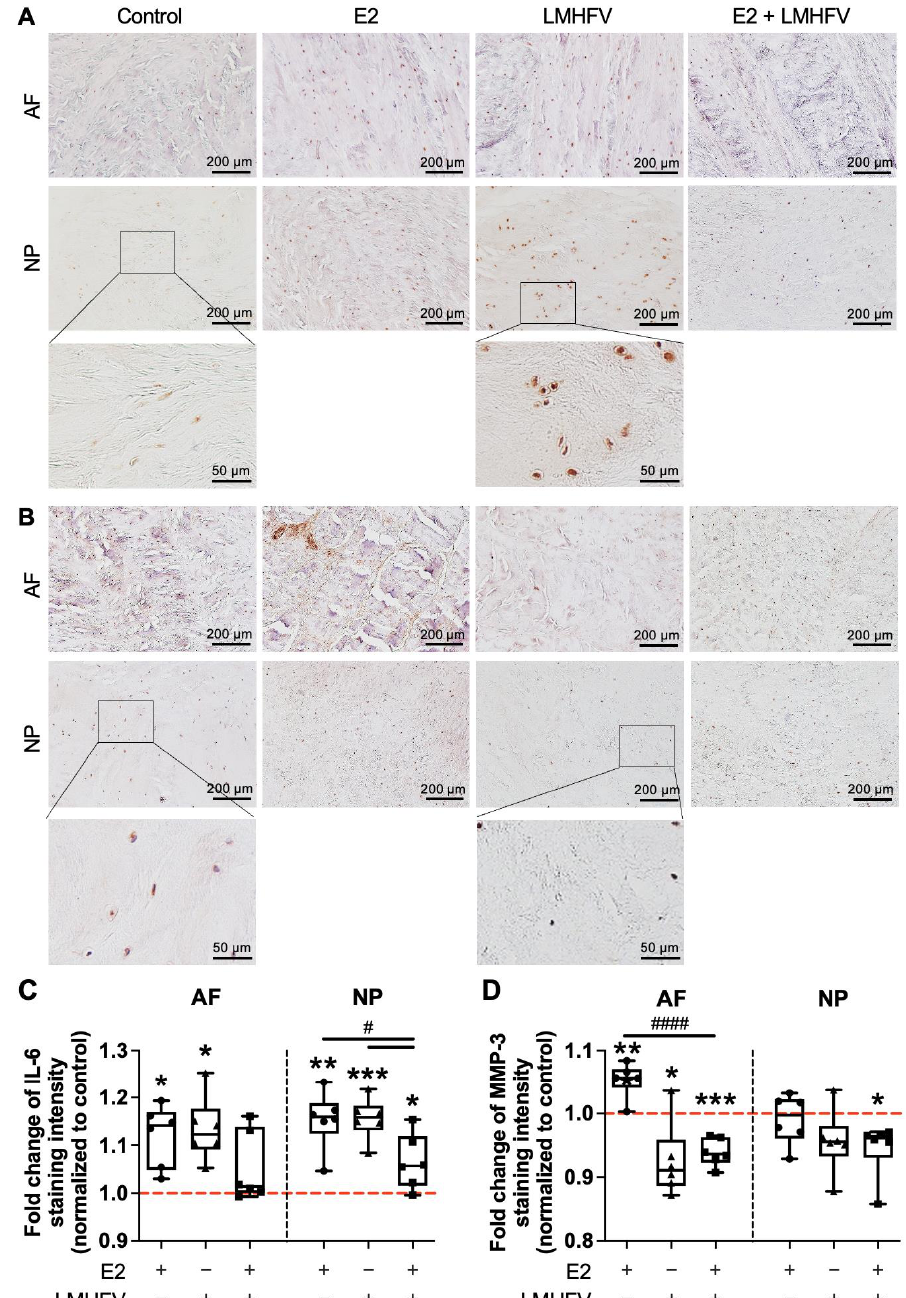
Figure 7. Representative images of AF and NP sagittal sections stained for ( A ) IL-6 and ( B ) MMP-3 in the control, E2, LMHFV and E2 + LMHFV groups after 21 days of IVD culture (scale bar, 200 µ m). Quantification of ( C ) IL-6 and ( D ) MMP-3 fluorescence intensity normalised to control (red dashed line = 1). Results are presented in box plots ( n = 6 IVDs/group). * p < 0.05, ** p < 0.01, *** p < 0.001 (*, comparison to the control); # p < 0.05, #### p < 0.0001 ( # , comparison to the E2 + LMHFV